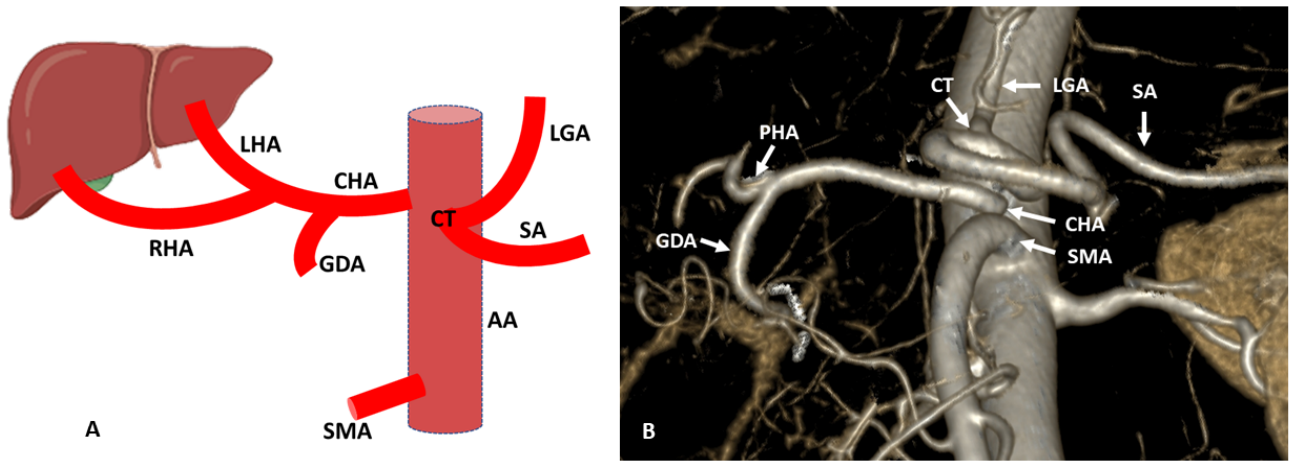
Figure 2. ( A ) Schematic representation of the origin of CHA from the aorta. ( B ) Three-dimensional (3D) volume render (3D-VR) image (64-row scanner CT angiography) of the abdominal